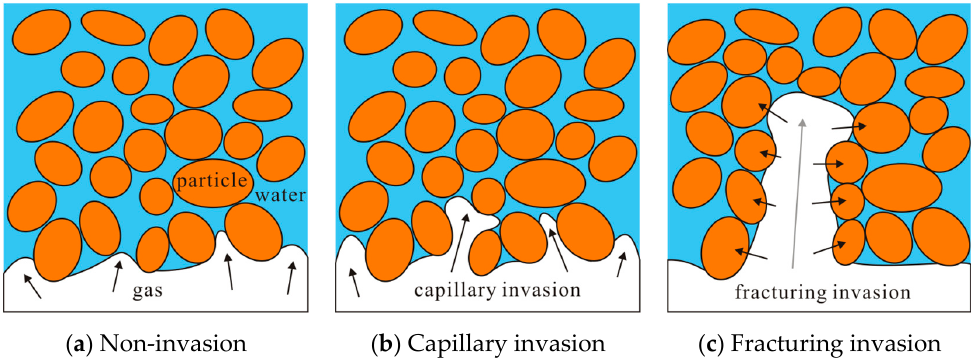
Figure 1. Schematic diagram of two modes of gas invasion in sediments.